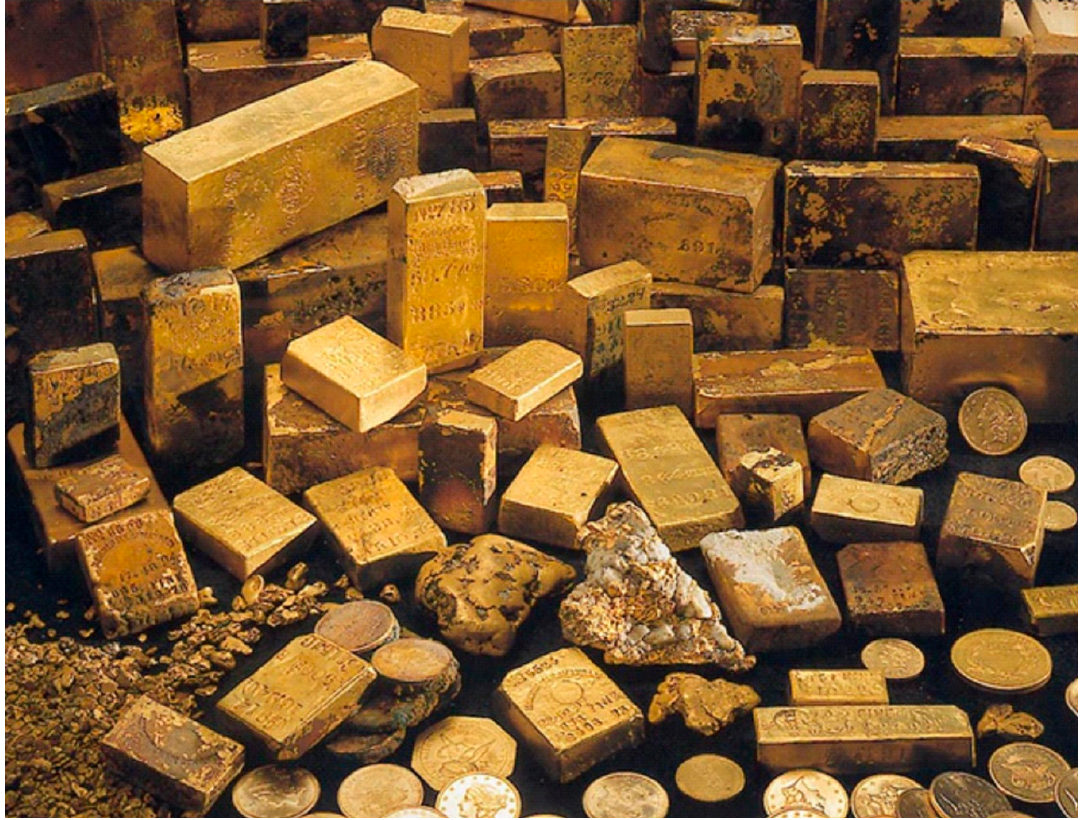
Figure 3. Image of some of the gold recovered from the shipwreck of the SS Central America after curatorial treatment. The black crusts have been retained on some assay bars (upper right and left) for esthetic purposes. Image courtesy of California Gold Marketing Group.